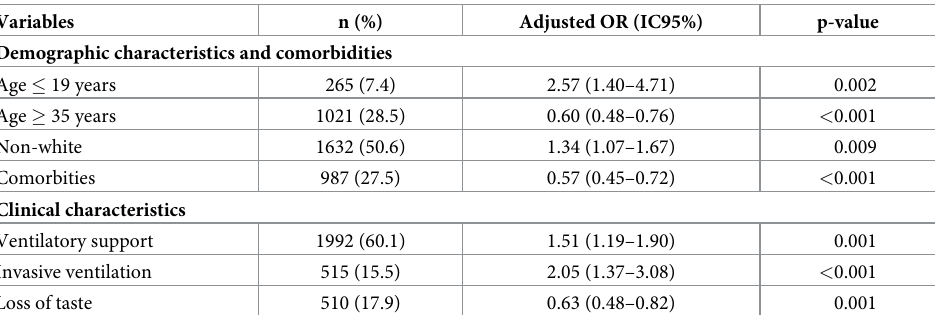
Table 3. Multiple logistic regression analysis of factors associated with the vaccination status against Covid-19 in pregnant and postpartum women with SARS. Brasil, 2021.